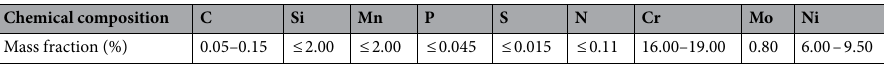
Table 2. X10CrNi18-8 stainless steel chemical composition.